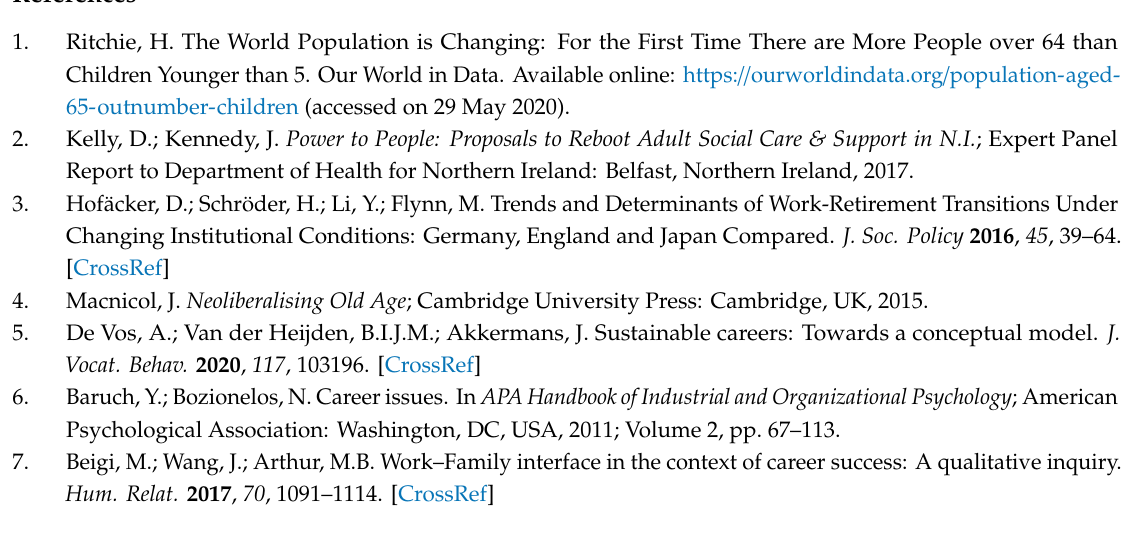
Table S1: Work Related Quality of Life - Regression, Table S2: Latent Class Analysis